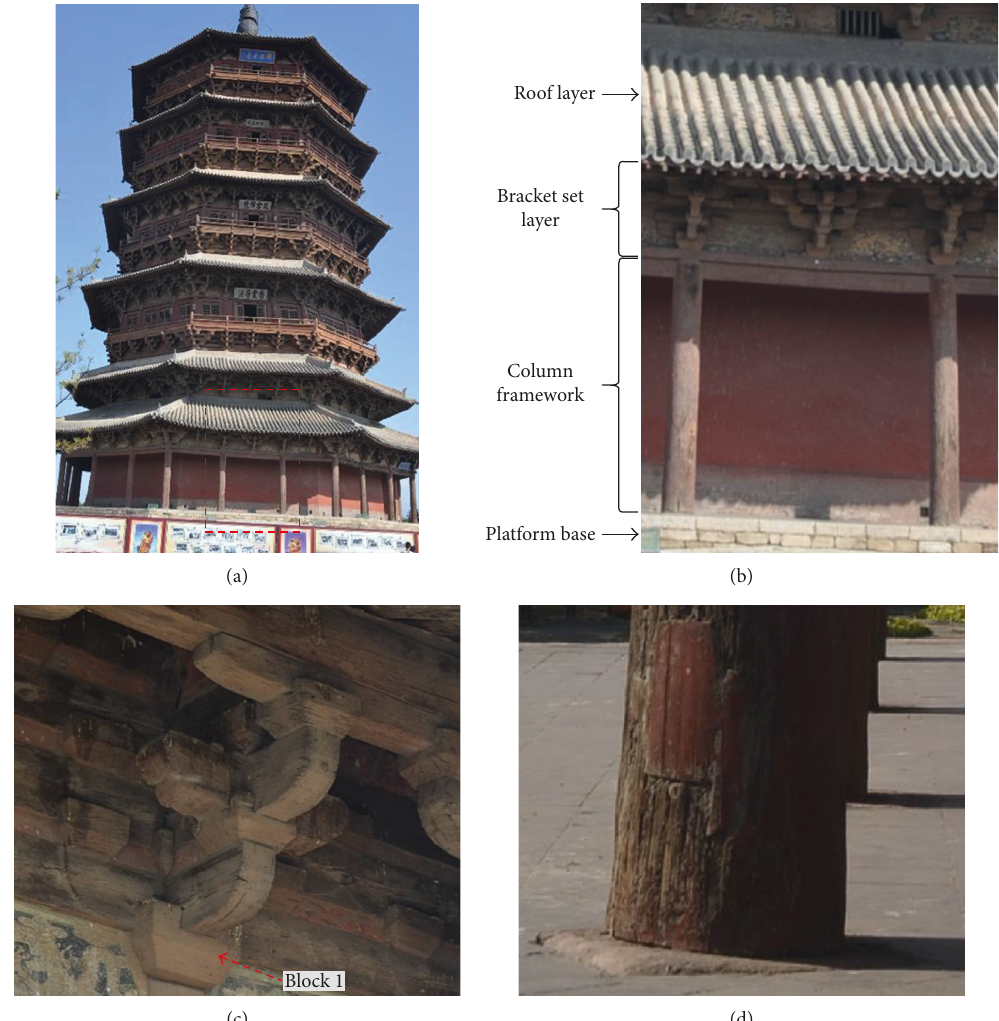
Figure 1: Traditional timber structures. (a) Yingxian Wooden Pagoda; (b) traditional timber structure; (c) bracket set; (d) the column base resting directly on a stone